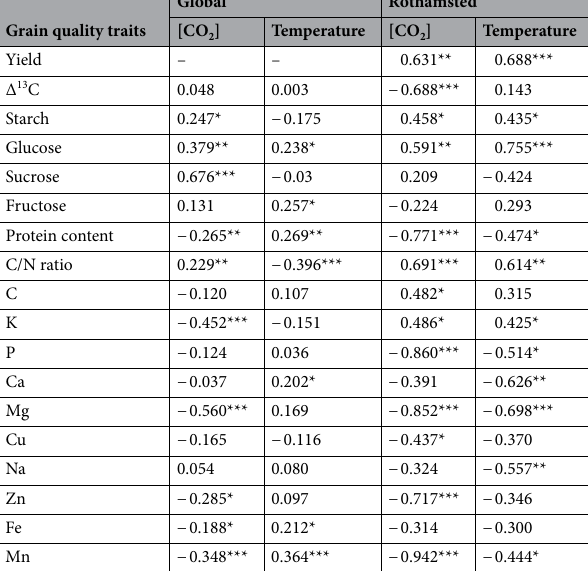
Table 5. Pearson correlation analyses (r) between grain yield and quality traits, and environmental factors ([CO 2 ] and temperature). Statistically significant effects are indicated with *** for p < 0.001, ** for p < 0.01 and * for p < 0.05. ‘–’ indicates unavailable coefficient of correlation